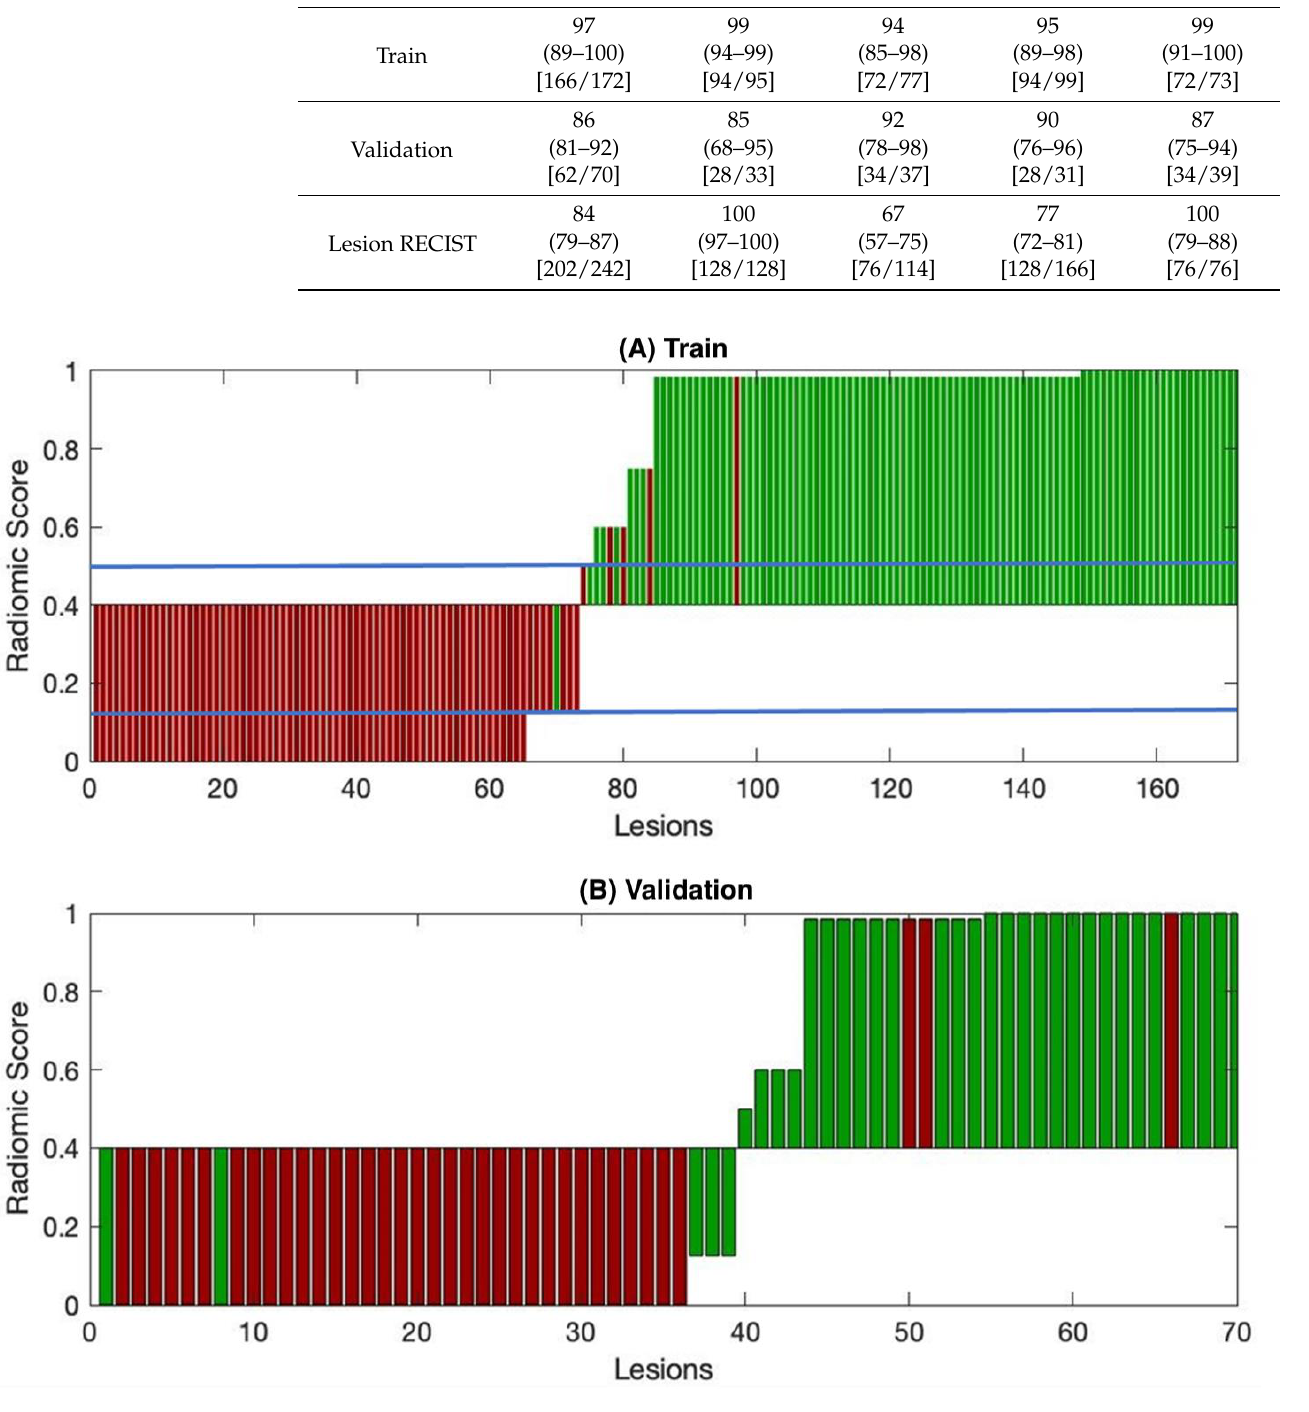
Figure 2. Waterfall plot of lesions included in the training ( A ) and validation sets ( B ). The green marks indicate the responder lesions, while the red marks represent the nonresponder lesions. All errors in the validation set (8) are visible as miscolored bars. The y -axis represents the radiomics score produced by the decision tree. The radiomics optimized cutoff is 0.4. Blue lines show the range (0.125–0.5) in which the cutoff could be modified without changing the prediction.